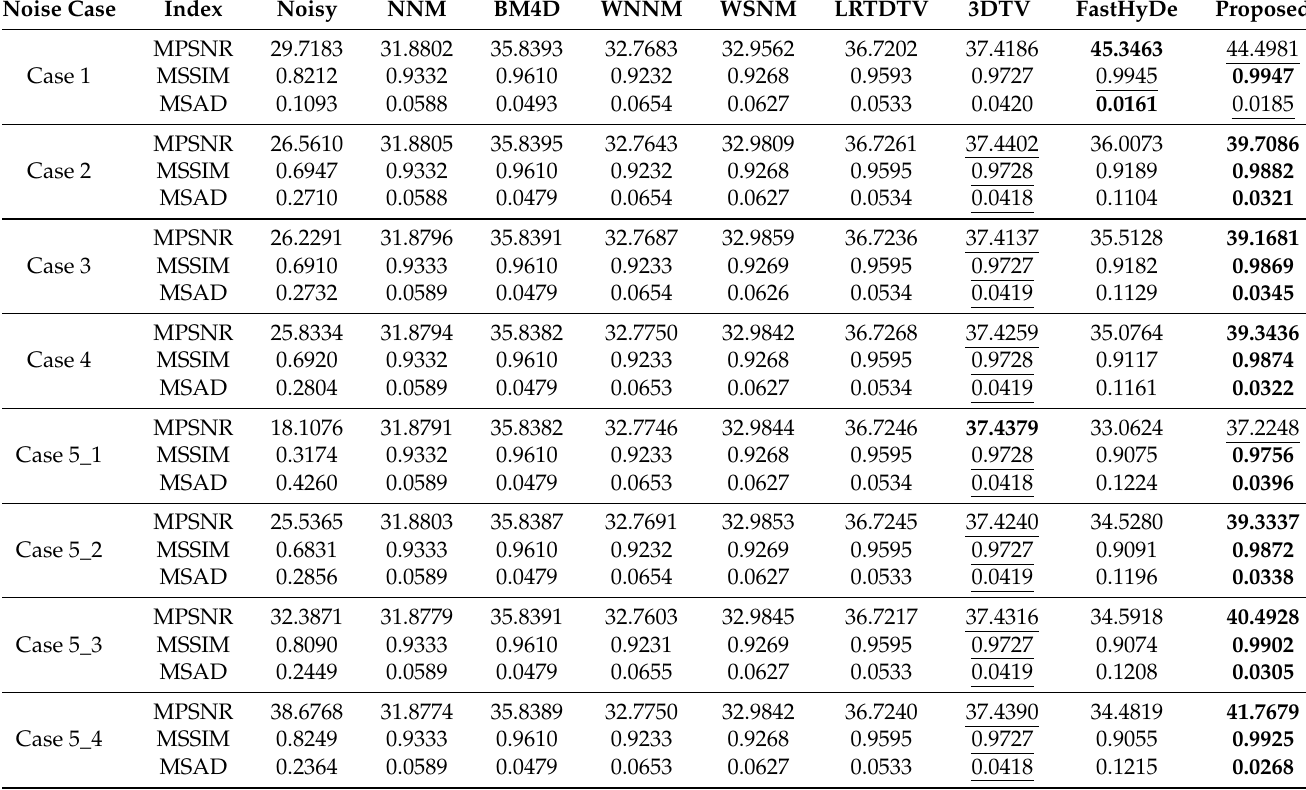
Table 1. Quantitative evaluation of the denoising results of different methods on five noise